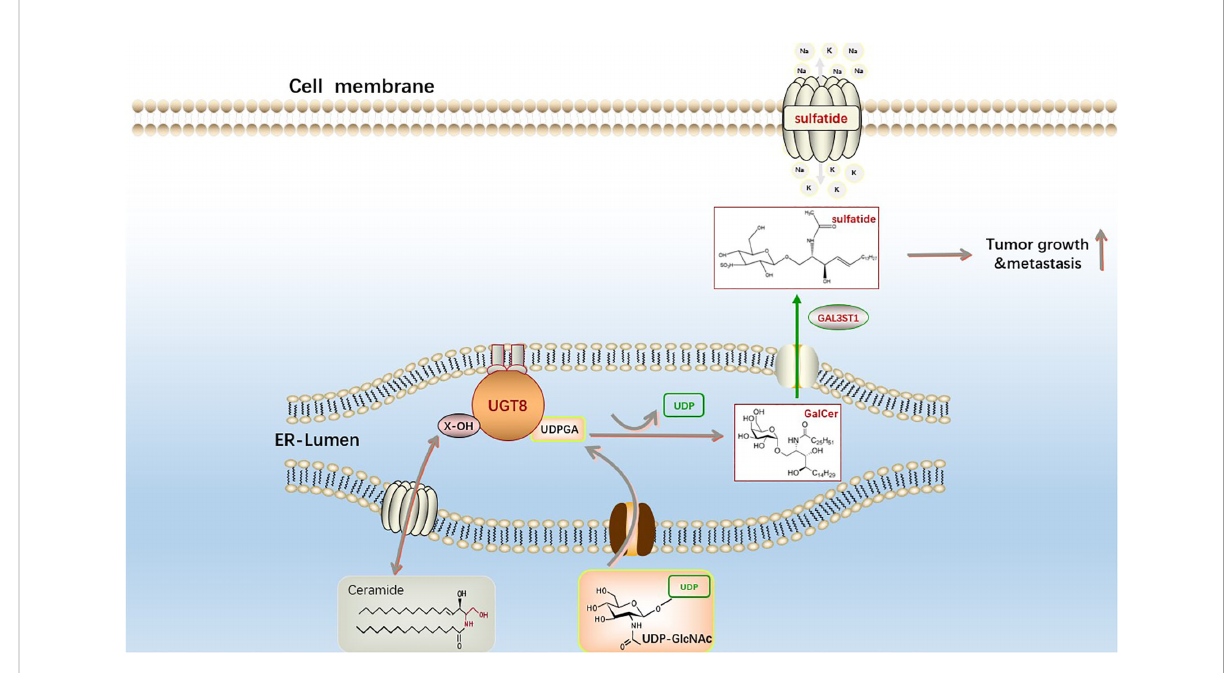
FIGURE 3 The synthesis pathway of sphingosine sulfatide. The fi rst step is catalyzed by UGT8 on the endoplasmic reticulum to generate GalCer and uridine diphosphate (UDP) from ceramide and uridine diphosphate galactose (UDP-galactose). The second galactoceramide transferase (GAL3ST1) in this reaction converts galactoceramide to Sulfatide via a sulfonation reaction. Sphingosine sulfatide on the cell membrane is involved in the regulation of proliferation, differentiation, apoptosis and senescence of cancer